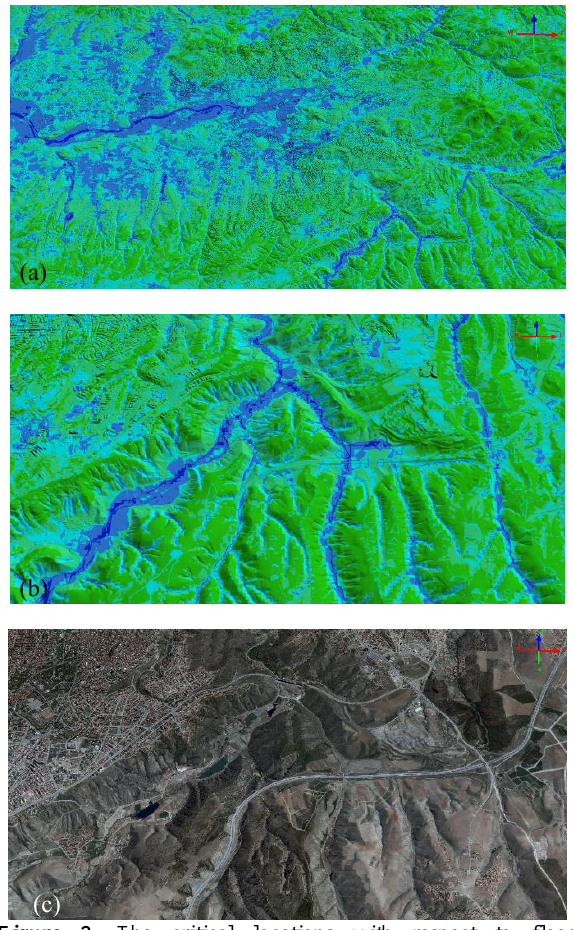
Figure 2. The critical locations with respect to flood susceptibility represented with the DTM; (a) mature width alluvial valley floors of the districts Yenimahalle and Etimesgut; (b) younger narrow alluvial valley bottoms of the district Cankaya; (c) orthoimage of (b) overlayed on the DTM.